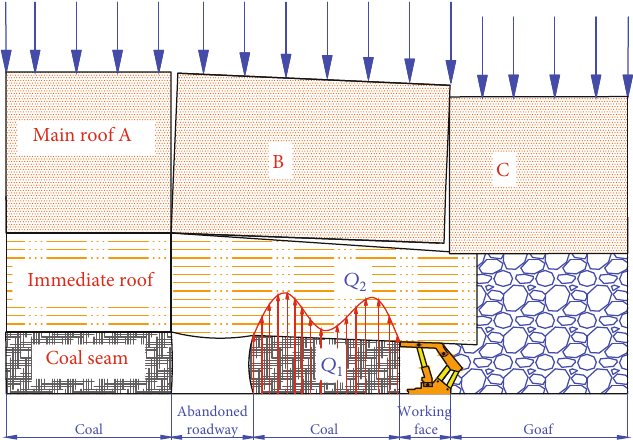
Figure 5: Schematic diagram of crossing the abandoned roadway during medium-term mining.